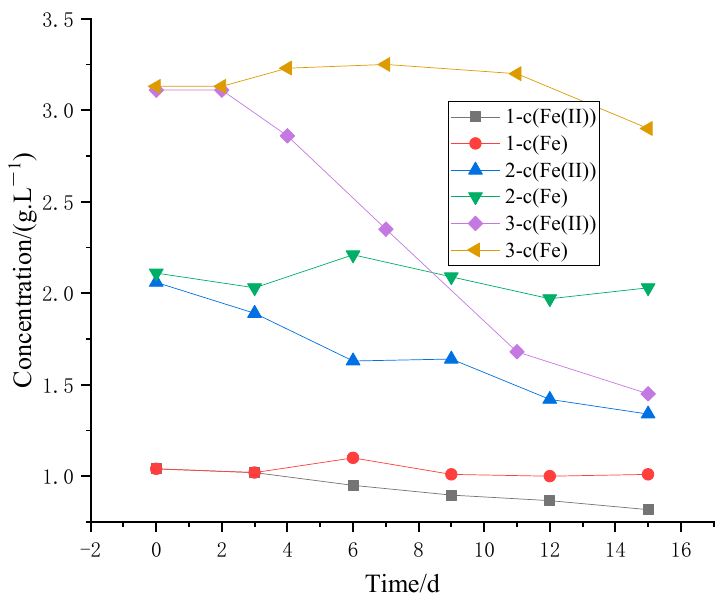
Figure 3. Oxidation of Fe(II) under different oxygen pressures.